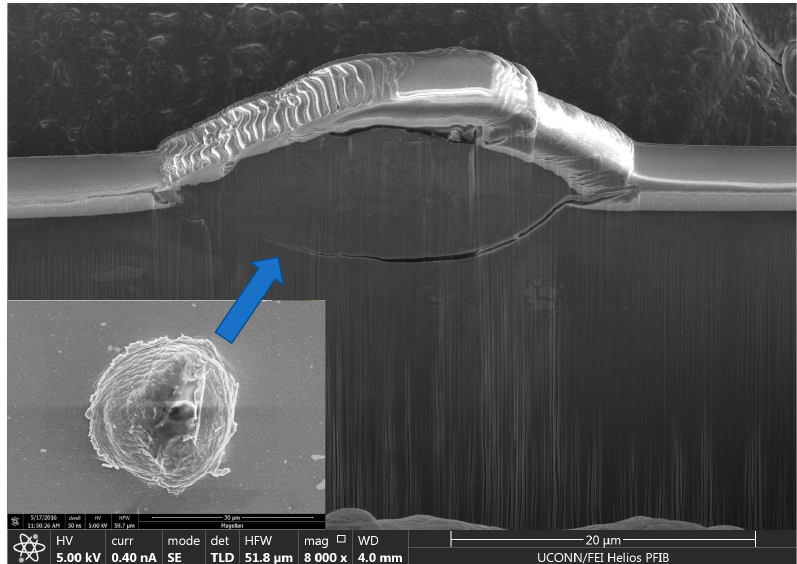
Figure 51. The embedded SEM micrograph is from the vantage point of the cold spray nozzle exit with respect to the gas-atomized Al 6061 single particle deposit. Otherwise, the figure at large presents the micrograph of the cross-sectioned Al 6061 single particle deposit prepared by way of plasma FIB. Note that the Pt on top of the particle deposit and substrate was applied to defend the sample surface during milling